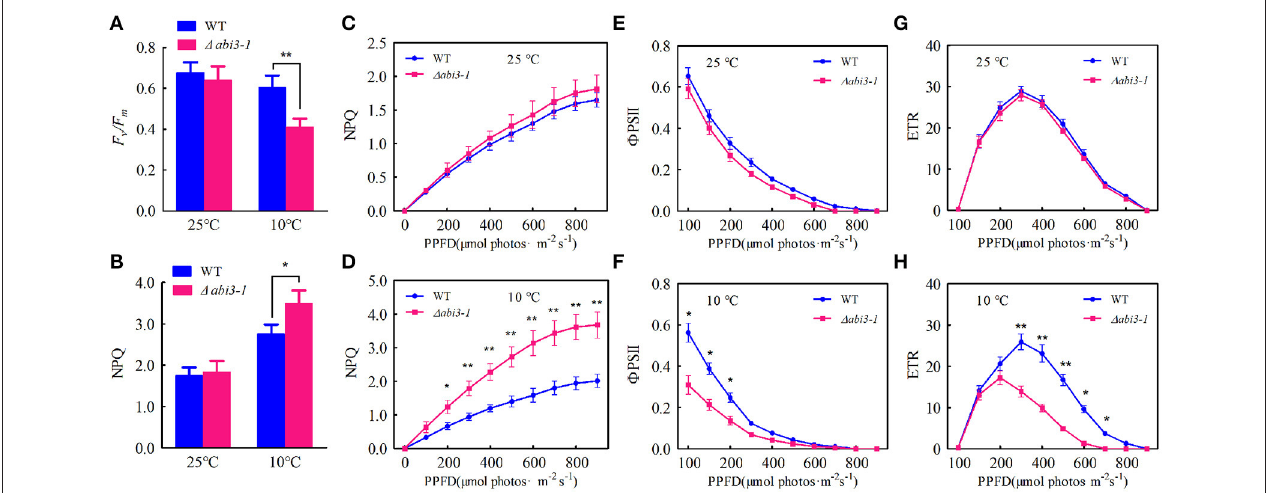
FIGURE 7 | Deletion of PpABI3 reduces PSII activity during cold acclimation. (A–H) Chlorophyll fluorescence analysis. Two-week-old protonema of WT and ∆ abi3-1 with or with cold acclimation were collected to determine the maximum photochemical efficiency of PSII ( F v /F m ) (A) , steady-state non-photochemical quenching (NPQ) (B) , light-response curves of non-photochemical quenching (NPQ) (C,D) , the efficiency of PSII quantum yield ( 8 PSII) (E,F) and PSII electron transport rate (ETR) (G,H) . Error bars represent SD ( n = 3), two-way ANOVA was used to determine the statistical significance (* P < 0.05; ** P < 0.01). Experimental details are found in the Materials and Methods.